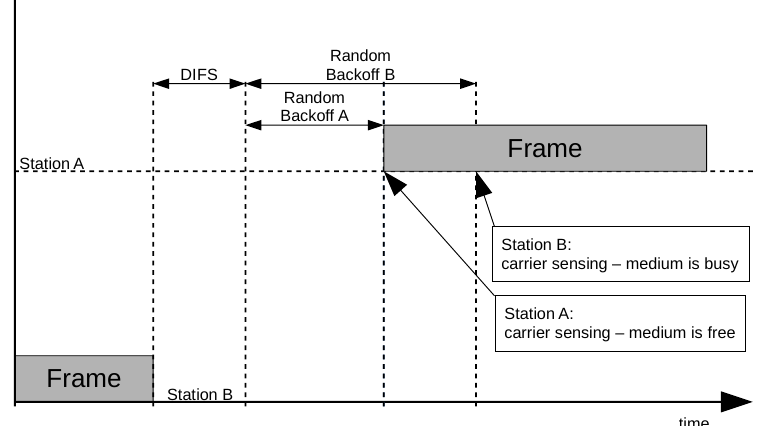
Figure 1. Example of medium access control in IEEE 802.11